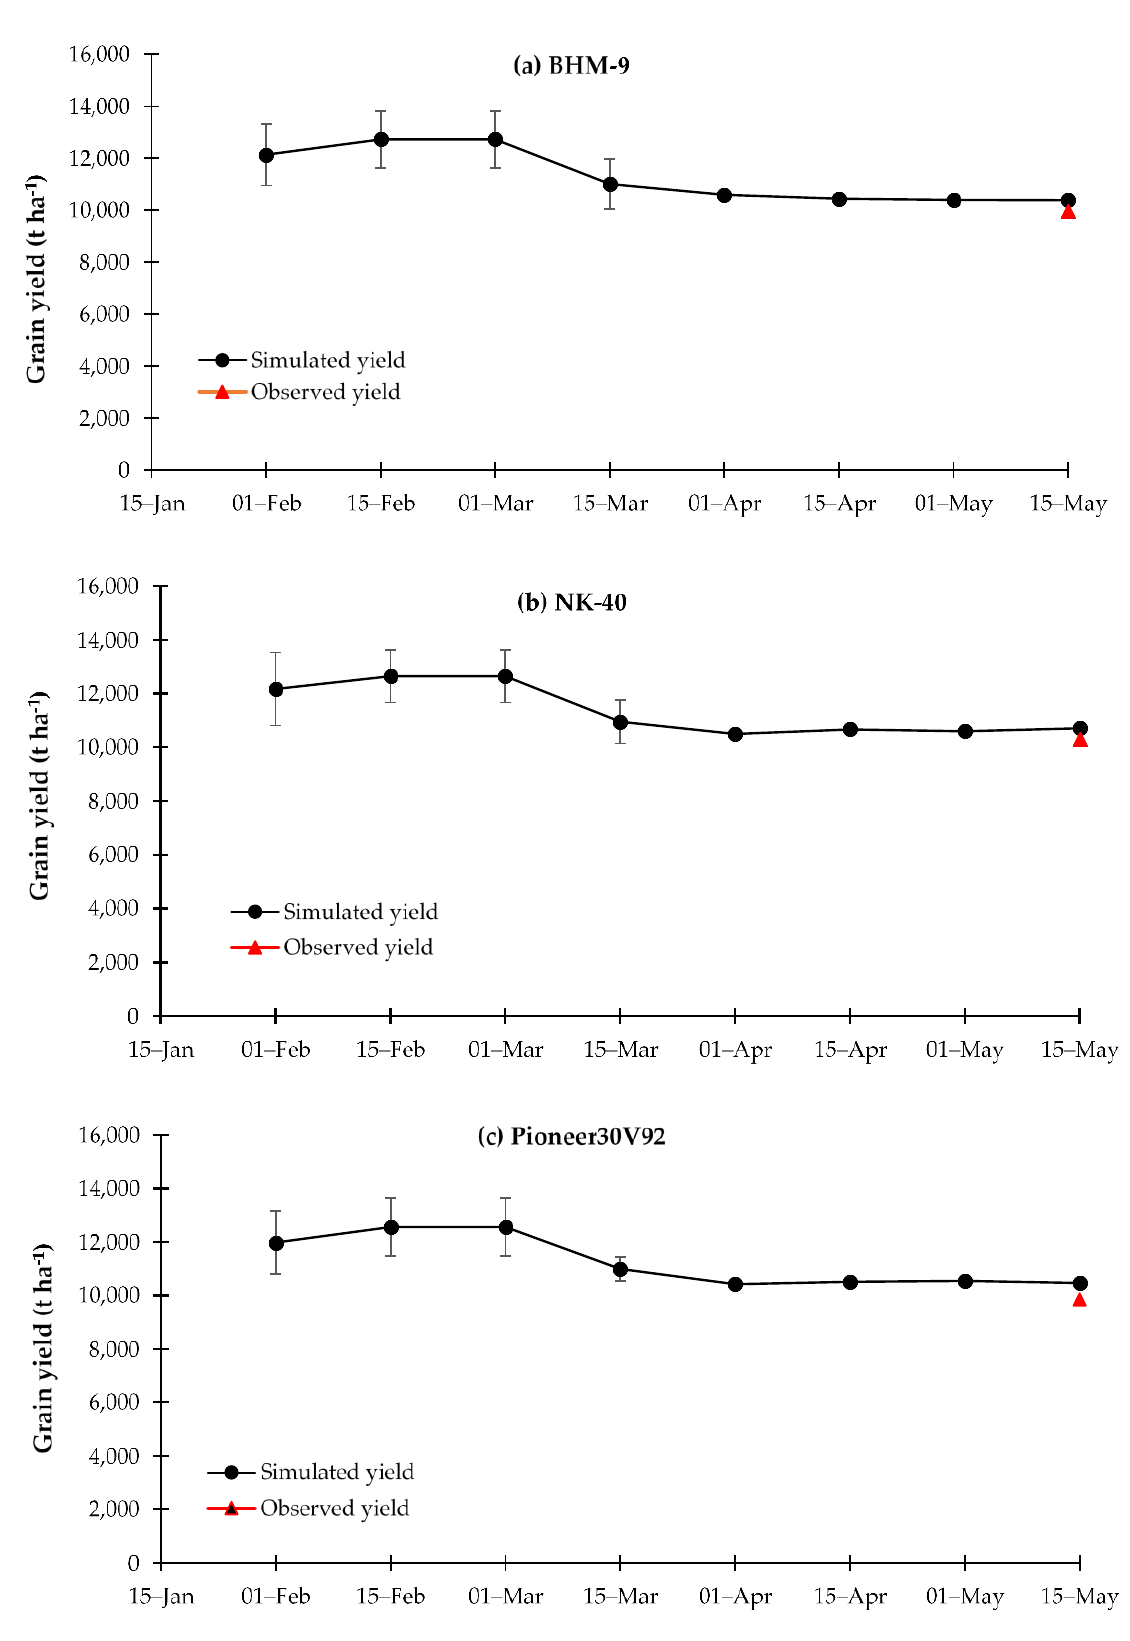
Figure 4. Average forecasted yield and standard deviation from the observed yield of the year 2017 considering the forecast date and yield (kg ha − 1 ) for maize ( a ) BHM-9, ( b ) NK-40, and ( c ) Pioneer30V92.